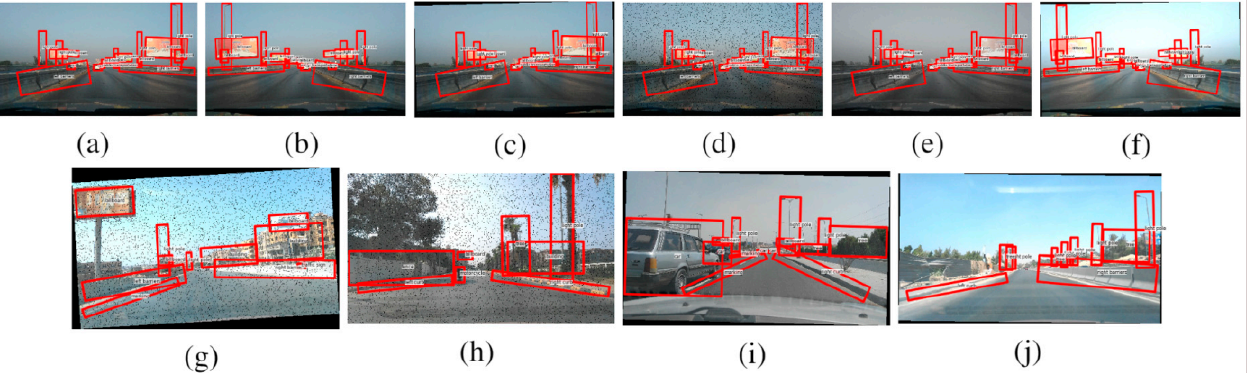
Figure 3. Samples of data augmentation. ( a ) Shows original image sample, and from ( b – e ) the effect of each augmentation method is shown; ( b ) horizontal flipping, ( c ) rotation, ( d ) adding noise, ( e ) changing brightness, and ( f ) shows the final augmentation pipeline result. ( g – j ) show four additional different output samples from the augmentation